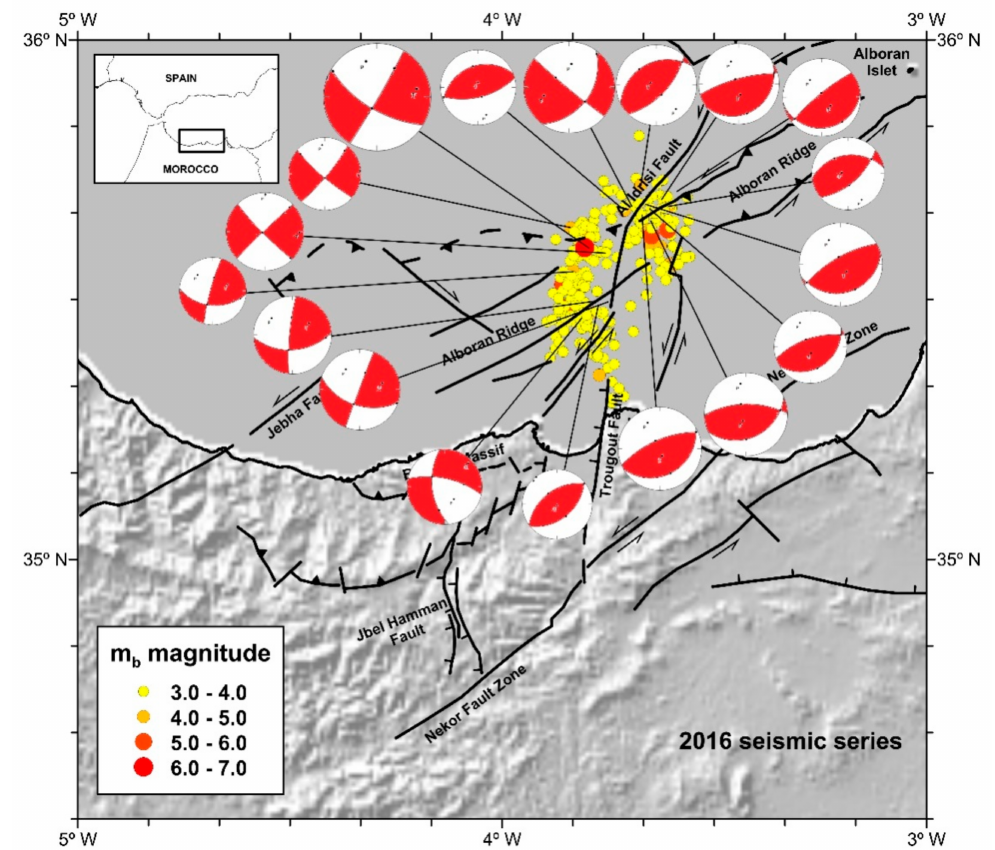
Figure 6. 2016 seismic sequence showing earthquakes with magnitude above 3.0 and computed focal